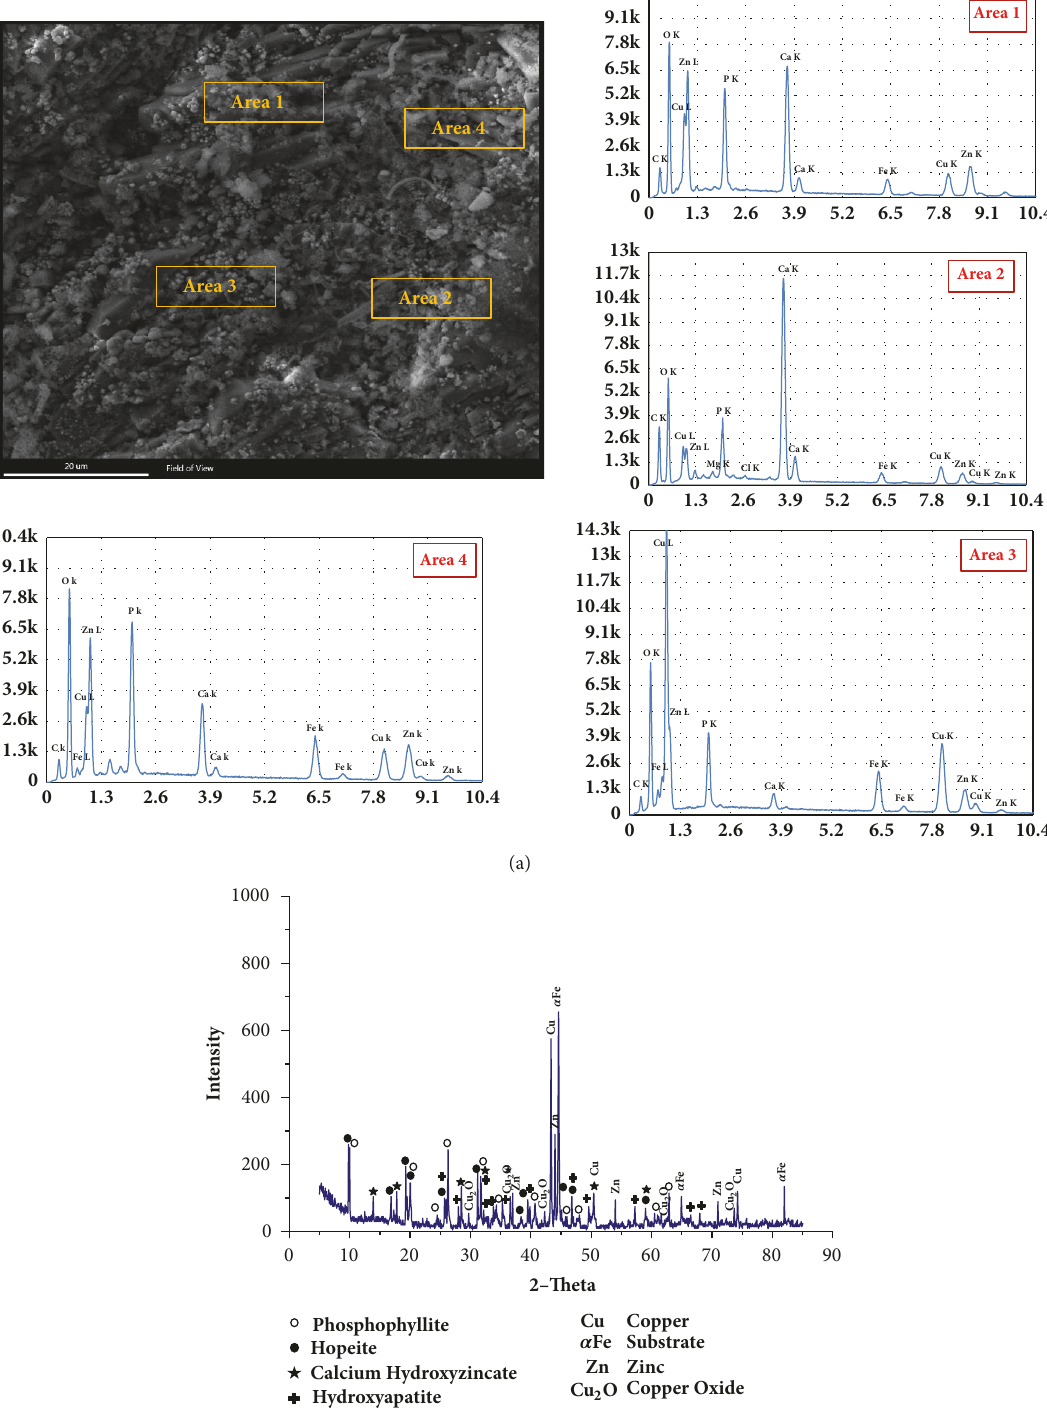
Figure 19: SEMs and EDX (a) and XRD analysis (b) of ZnP-Cu coating after immersion in (CH-Cl) solution for 96